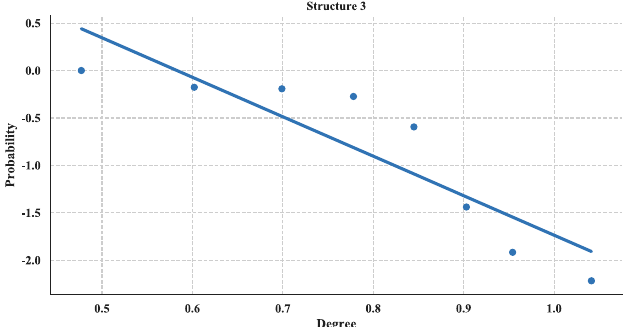
Figure 20. Cumulative Distribution of degree of Structure 3.